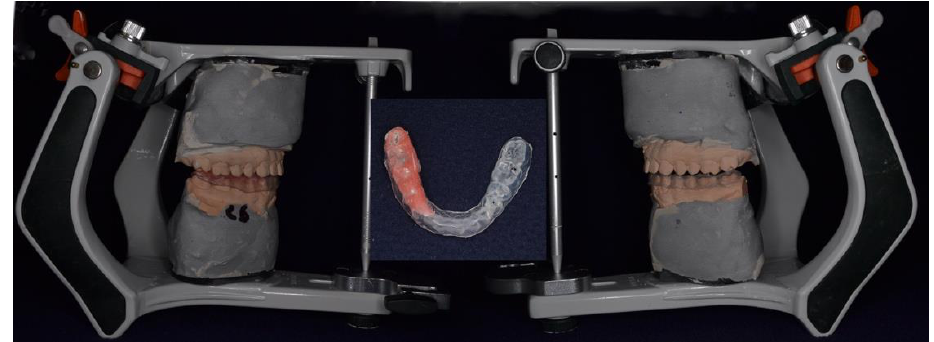
Figure 1. Cast mounted in semi-adjustable articulator and rigid mandibular splint design.